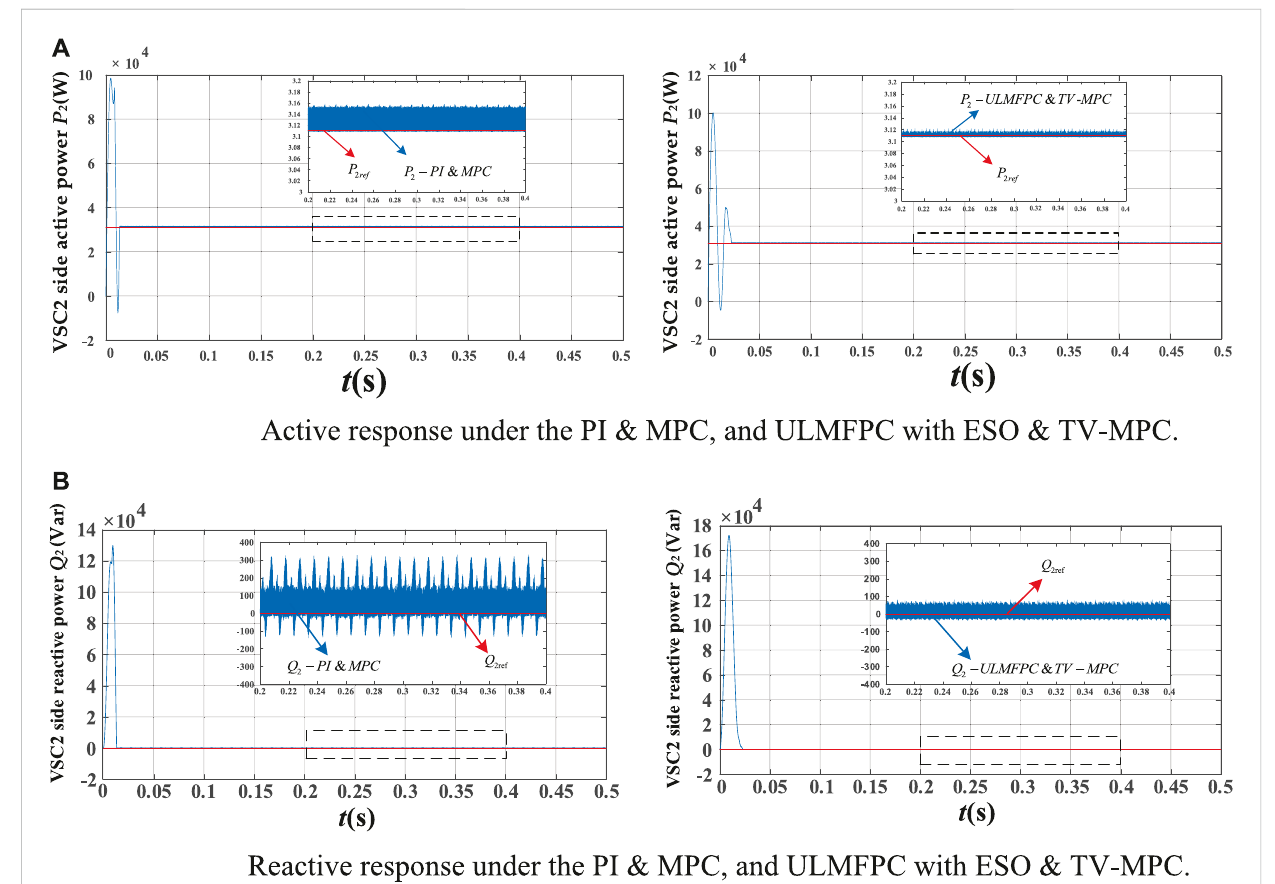
FIGURE 10 (A) Active response under the PI & MPC, and ULMFPC with ESO & TV-MPC. (B) Reactive response under the PI & MPC, and ULMFPC with ESO & TV-MPC.